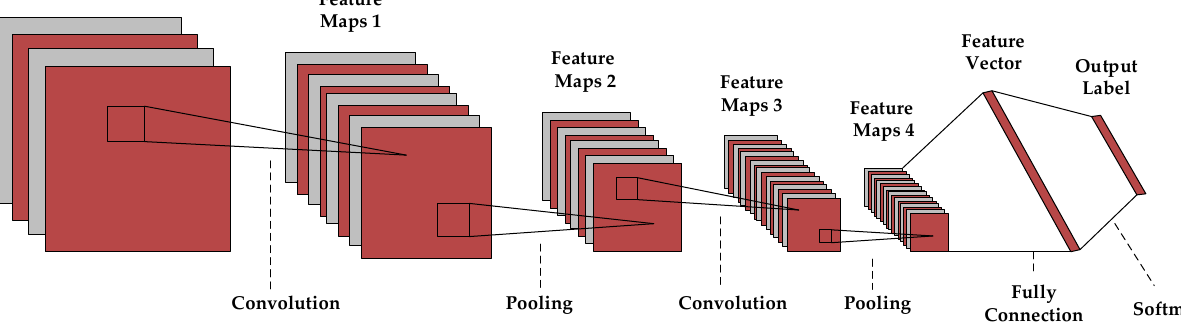
Figure 1. Illustration of typical 2DCNN structure.